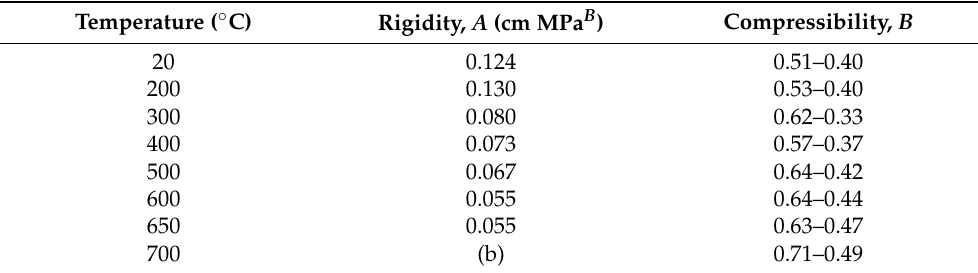
Table 1. Mechanical rigidity A and compressibility B (at low to high pressure) of melamine sponge coated with 27.4 wt% polypyrrole and exposed to various temperatures a .